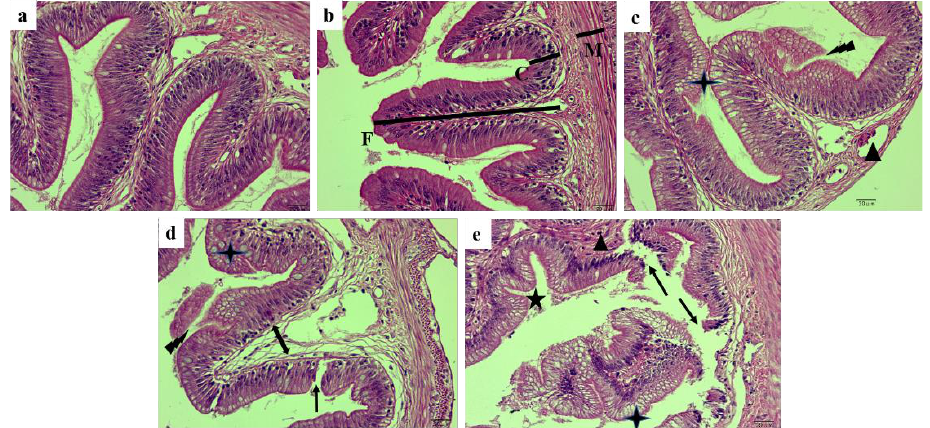
Figure 1. H&E-stained section of the posterior intestinal from hybrid yellow catfish fed with different glycinin levels. ( a ), the control; ( b ), 2% glycinin; ( c ), 4% glycinin; ( d ), 6% glycinin; ( e ), 8% glycinin. Triangles show lymphocyte infiltration; four-pointed stars show goblet cell hyperplasia; five-pointed stars show the bending of intestinal folds; lightning shapes show the proliferation and exfoliation of intestinal epithelial cells; single arrows show disrupted intestinal folds; double arrows show the separation of the inherent layer. F, Height of fold; C, Crypt depth; M, Thickness of muscle layer. Magnification was 400×, and the scale represents 20 μm.